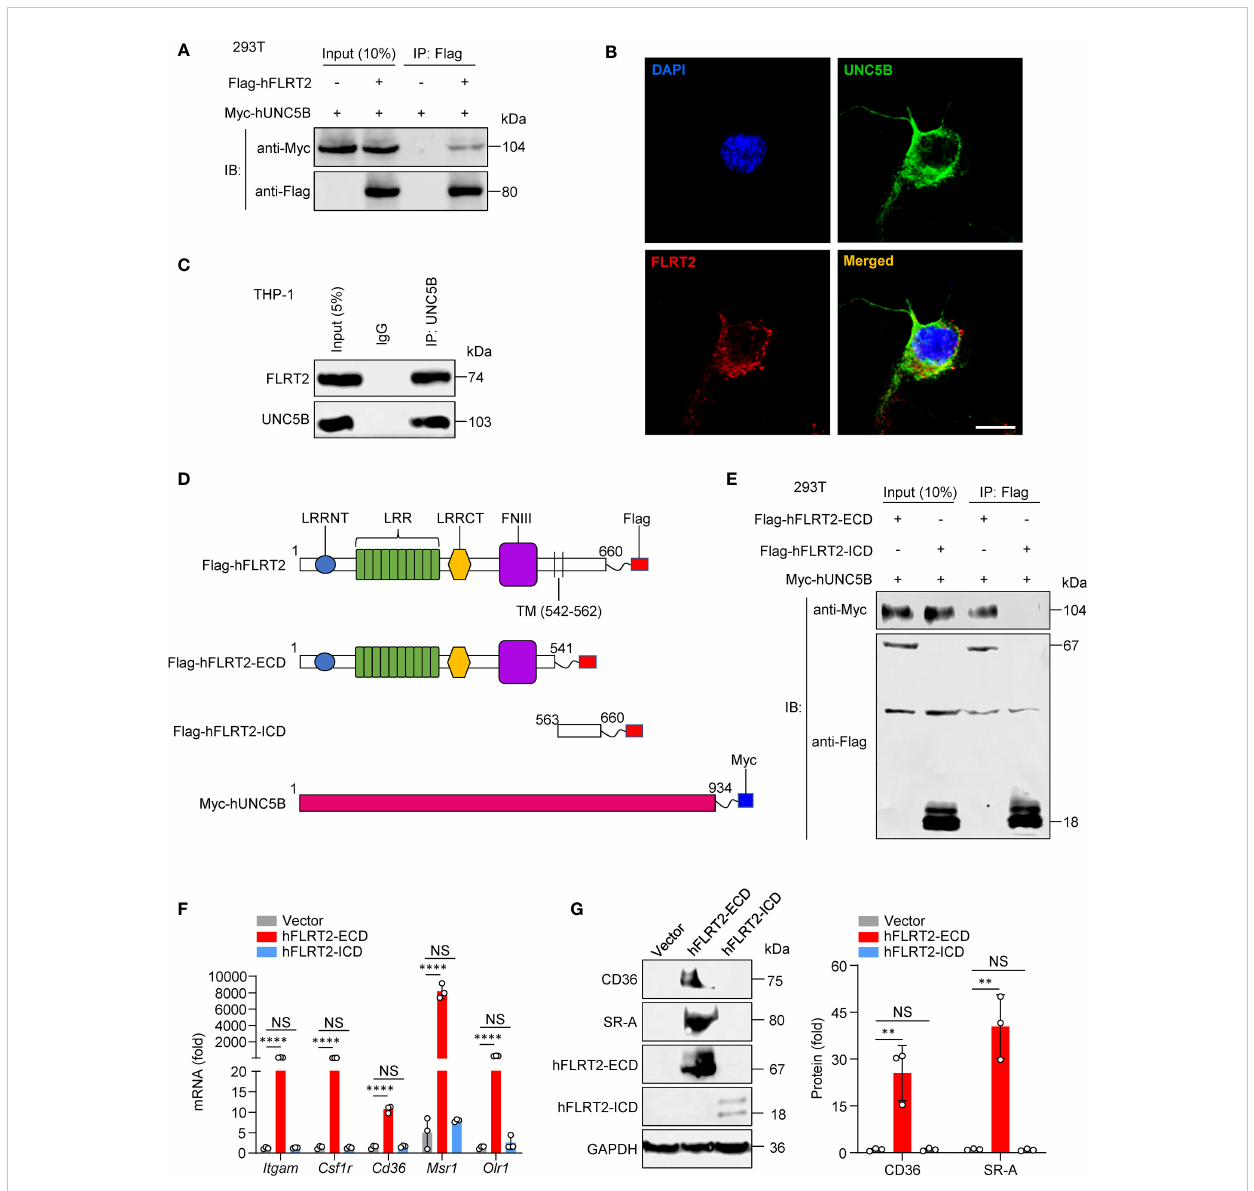
FIGURE 5 The direct interaction of the FLRT2 ECD with UNC5B is required for FLRT2-promoted THP-1 cell differentiation into macrophages. (A) Myc-tagged hUNC5B and/or Flag-tagged hFLRT2 were transfected into HEK293T cells. Immunoprecipitation samples were collected using anti-Flag antibody, followed by immunoblotting for Myc and Flag (n = 3). (B) Immunolabeling of FLRT2 and UNC5B in PMA-treated THP-1 cells showing the colocalization of endogenous UNC5B and FLRT2. Scale bar, 10 m m. (C) UNC5B was immunoprecipitated from PMA-incubated THP-1 cells,